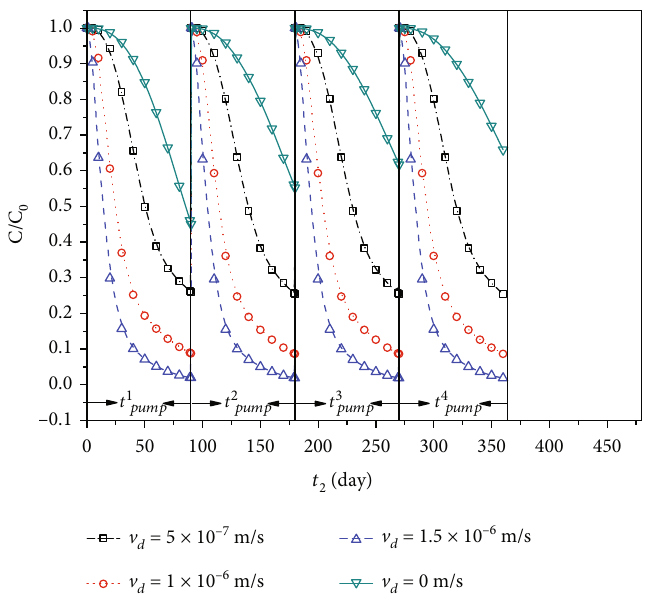
Figure 4: BTCs for di ff erent values of v d inside the well in the pumping